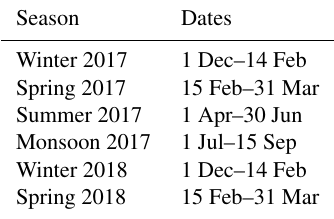
Table 2. Periods for seasonal PMF